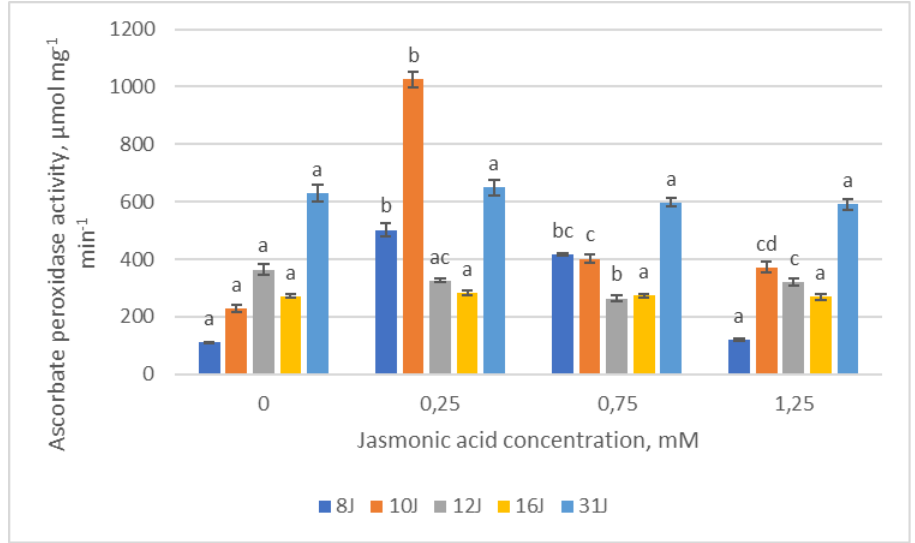
Figure 10. Means (µmol mg − 1 min − 1 ) ± SE of ascorbate peroxidase (APX) activity in five half-sib families of Scots pine, assessed 6 weeks after sowing. Data significance was calculated using the Kruskal – Wallis H test for ranks and post hoc Dunn ’ s test for pairs ( p < 0.05). Different letters next to different colors indicate significant differences between the groups, sprayed with different concentrations of jasmonic acid.